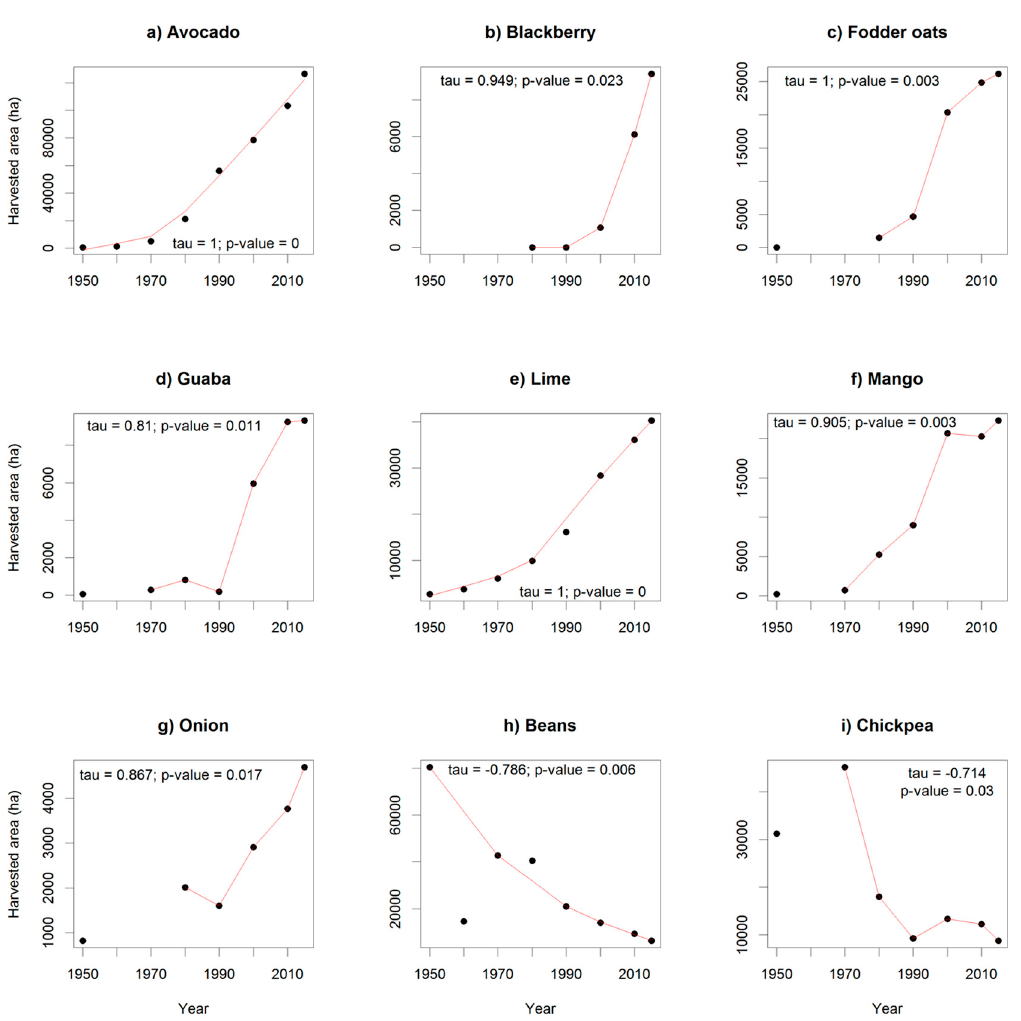
Figure 2. Harvest area by crop with significant (positive or negative) changes from 1950 to 2015, the red line is lowess smoother. ( a ) Avocado, ( b ) Blackberry, ( c ) Fodder oats, ( d ) Guava, ( e ) Lime, ( f ) Mango, ( g ) Onion, ( h ) Beans, and ( i ) Chickpea. Table 3. Harvested area trends for each crop in Michoacán state from 1950 to 2015.